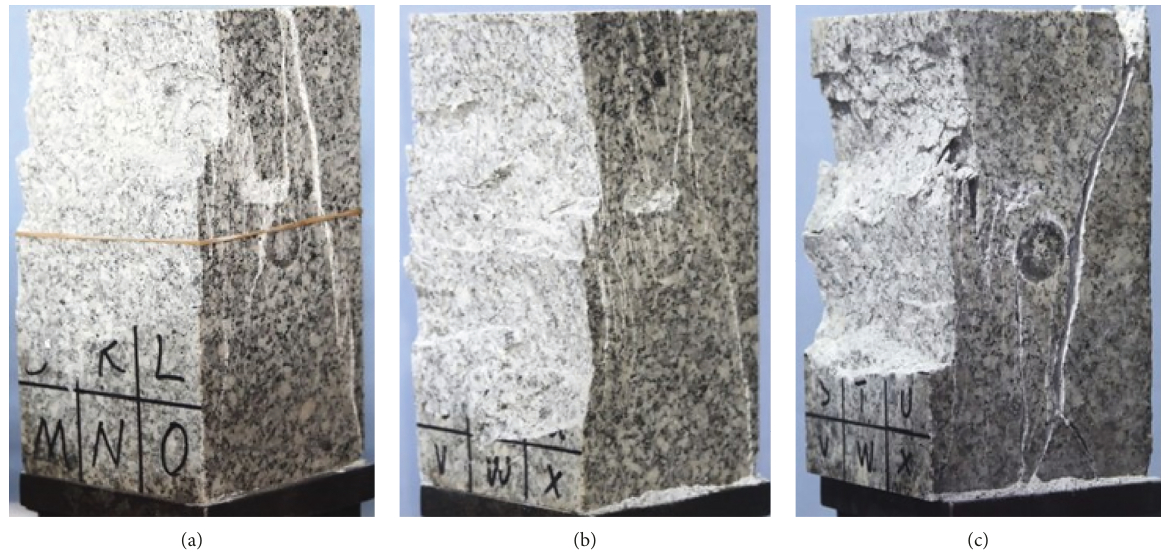
1 / σ max (cid:31) 50%; (b) σ 1 / σ max (cid:31) 77%;